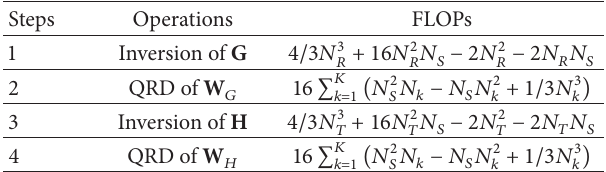
Table 2: Complexity of BD-GZF.